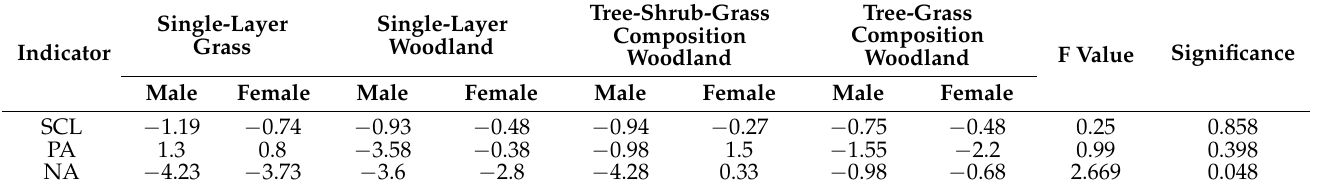
Table 4. Effects of gender and plant community type on physiological and psychological